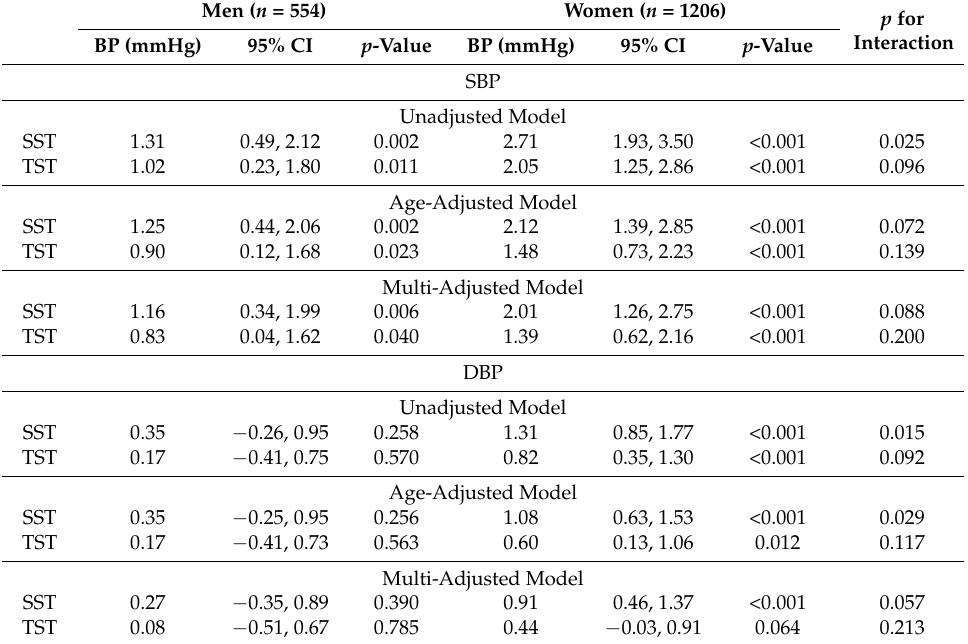
SST and TST were analyzed in separate regression models. Multi-adjusted model: adjusted for smoking, alcohol drinking, fasting glucose, TG, TC, and HDL-C in addition to age-adjusted model. Abbreviations: BP: blood pressure;